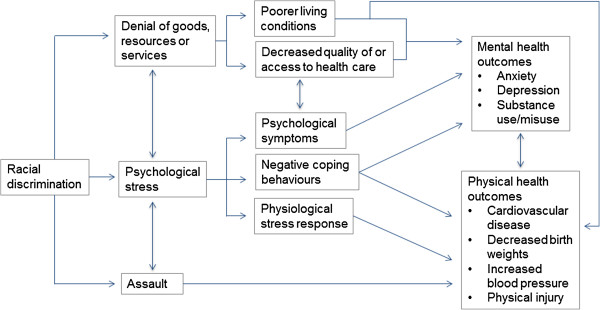
Pathways between racism and health[13].